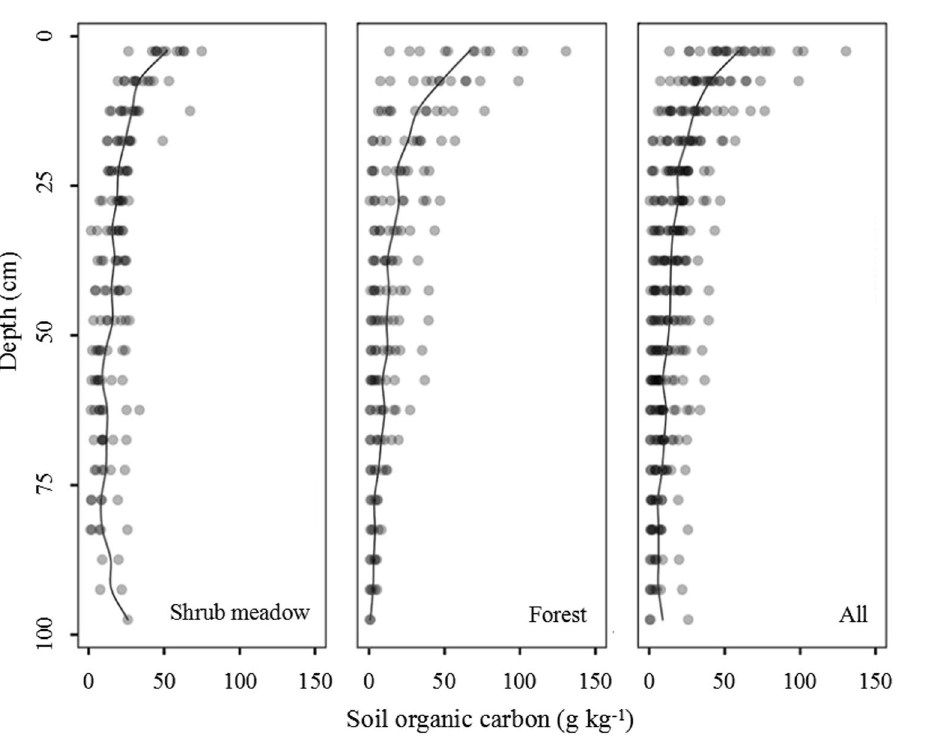
Figure 1. Vertical distributions of soil organic carbon in the soil